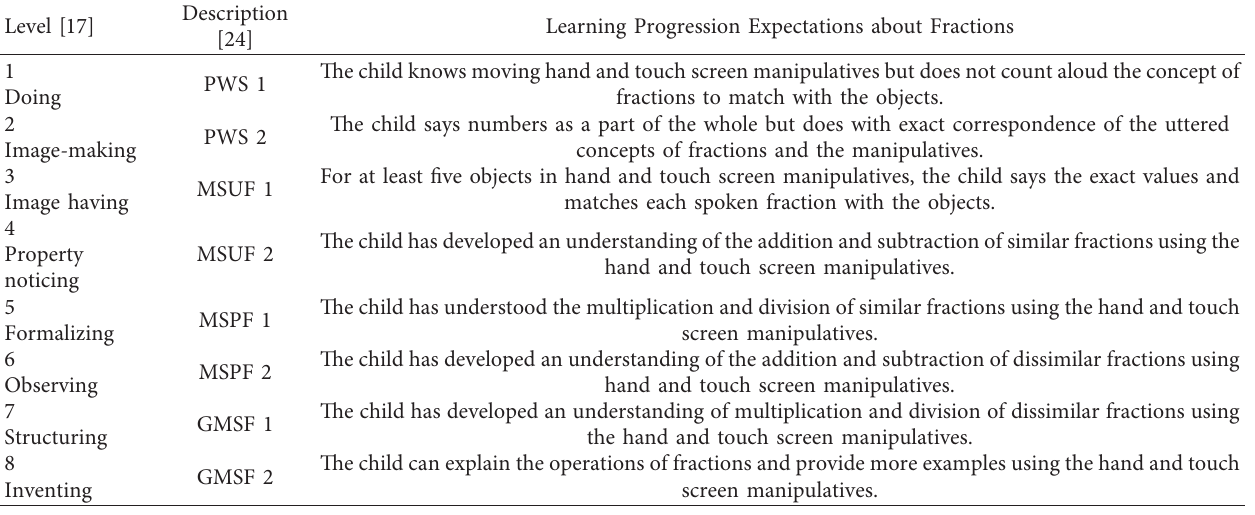
Table 1: Checklist on learning progression in the operations of fractions based on the Pirie–Kieren theory Approach. Level